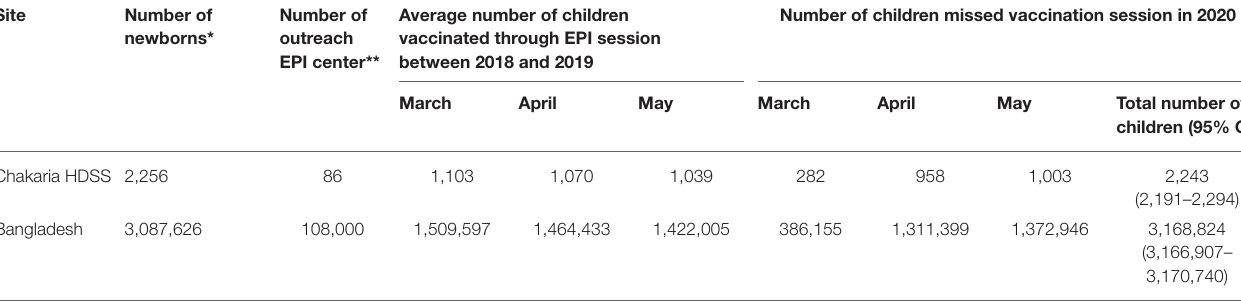
TABLE 3 | Number of children missed EPI session between March and May, 2020.